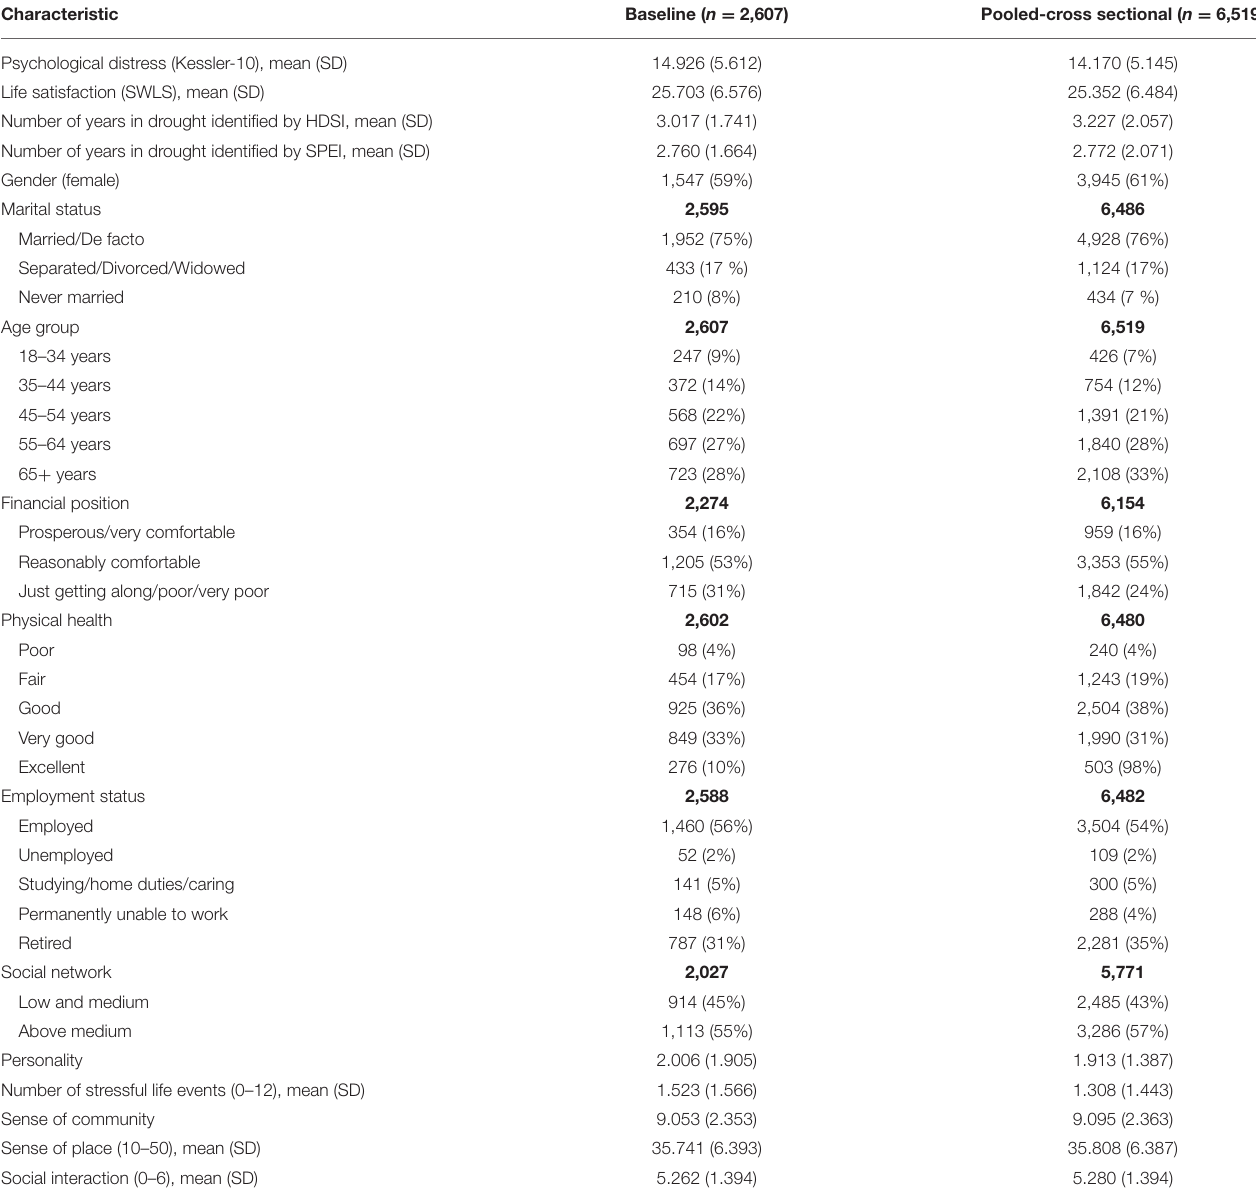
TABLE 1 | Participants characteristics at baseline and pooled-cross sectional, n